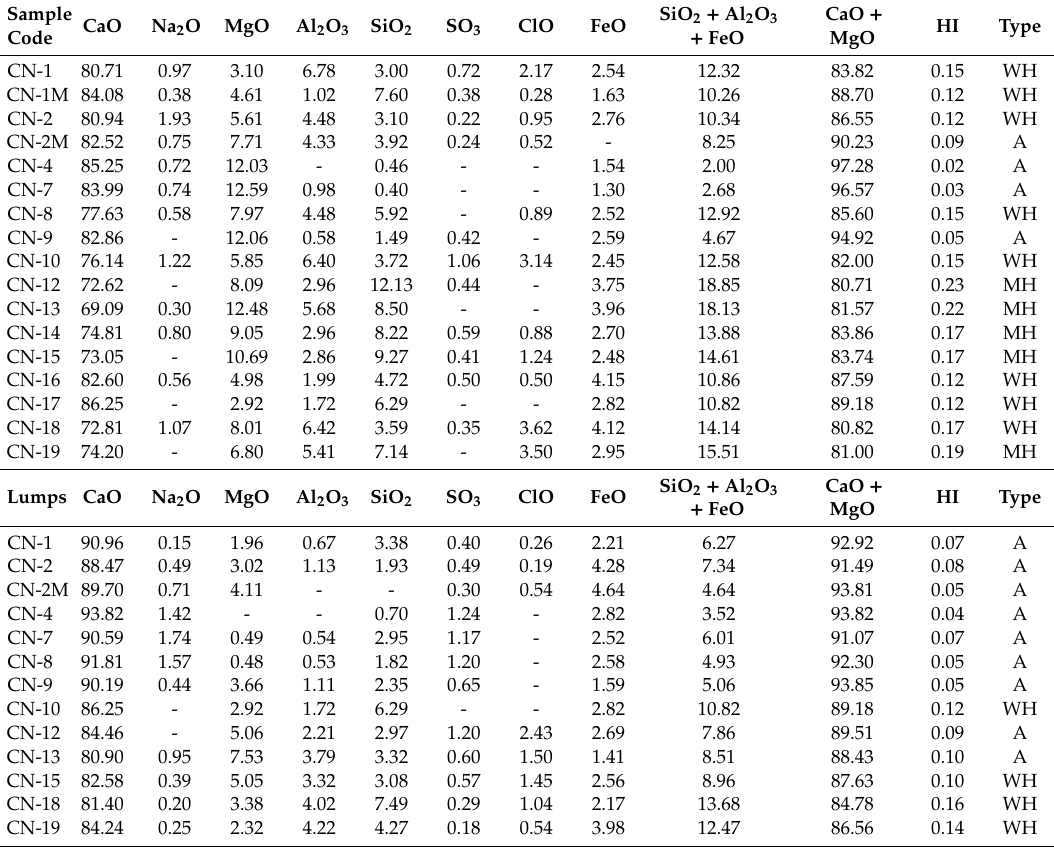
Table 3. Average values of major oxides (wt%) determined through electron probe micro analysis energy-dispersive spectroscopy (EMPA-EDS) analysis of binder and lumps. Sample